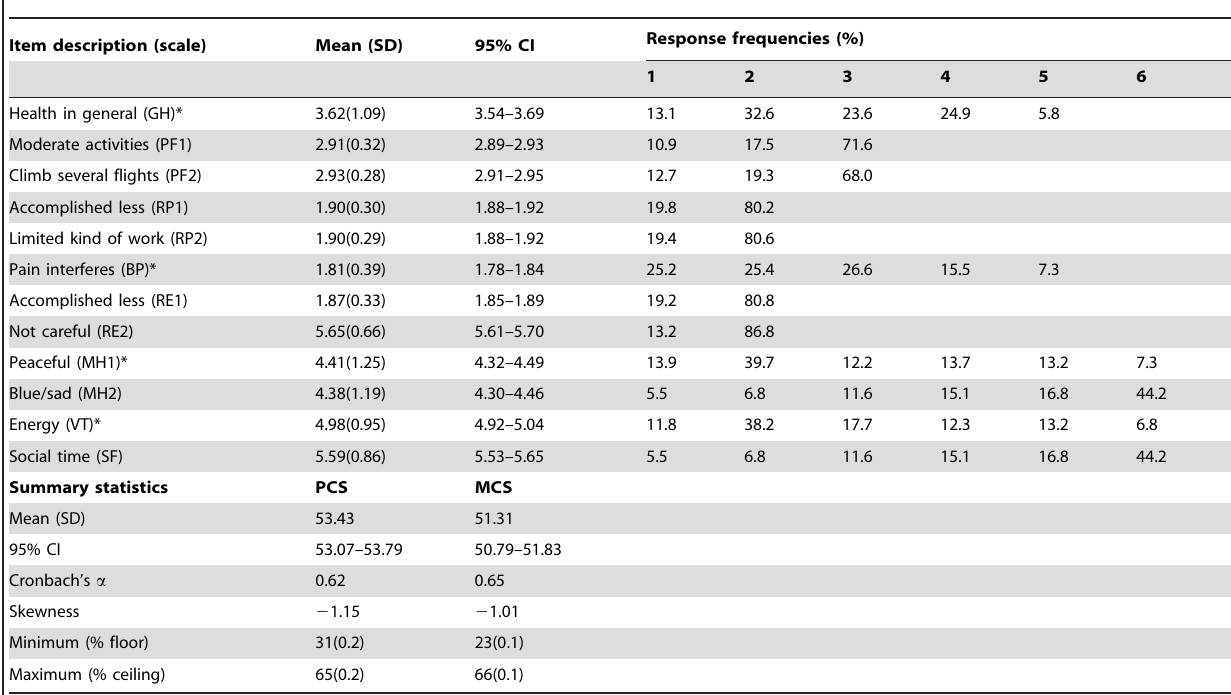
Table 2. SF-12 item and summary descriptive statistics (N